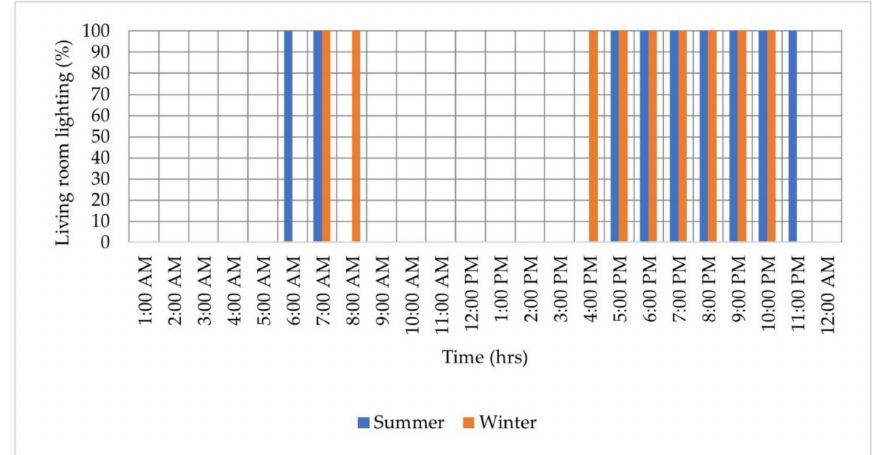
Figure A3. Lighting schedule of living room.